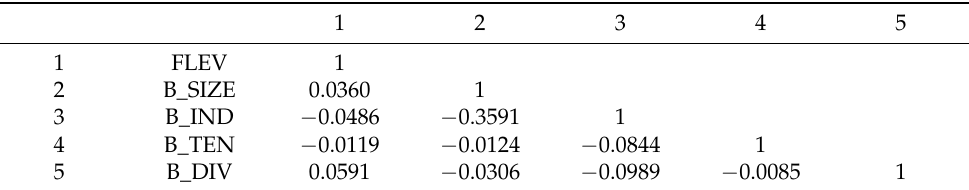
Table 3. Correlation matrix.